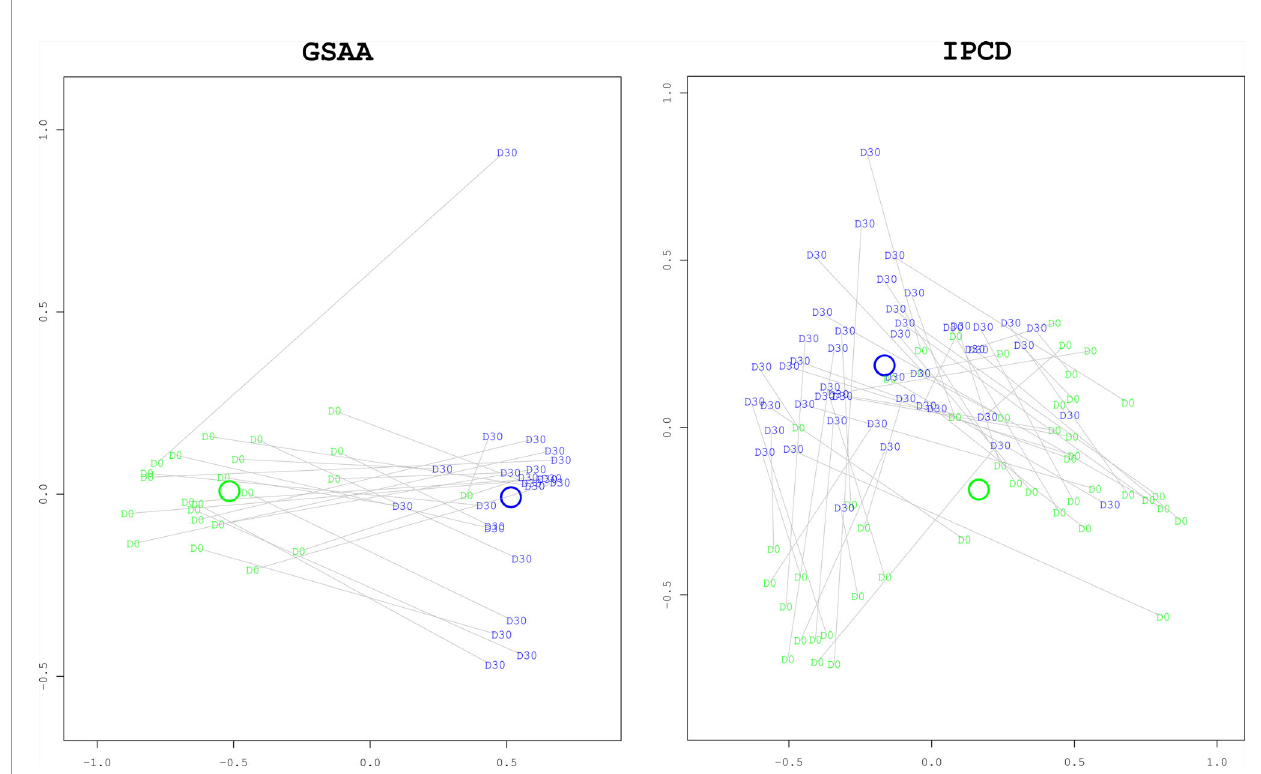
FIGURE 5 | Multidimensional Scaling (MDS) plots comparing Baseline to Day 30 for Survivors. These ordination plots generated with the MDS algorithm illustrate that the overall composition of the survivors at day 30 ( “ D30 ” , blue) have changed signi fi cantly from baseline at day 0 ( “ D0 ” , green). The two dimensional (x and y axes) spatial relationships of the samples represent the degree of difference of taxonomic composition between the samples. Paired day 0 and day 30 samples from the same mouse are connected with grey lines. The x and y axes are unitless representations of the sample distance/dissimilarity estimated by the MDS algorithm. In both experiments, the difference in composition, as measured by the Manhattan distance, was statistically signi fi cant with bootstrapped p-values < 0.0001. As can be visually con fi rmed, the distance between the centroids of each group (represented by the green and blue annuli, representing day 0 and day 30, respectively) is greater than the dispersion within each group (the average distance between a group ’ s centroid and each of the members in the